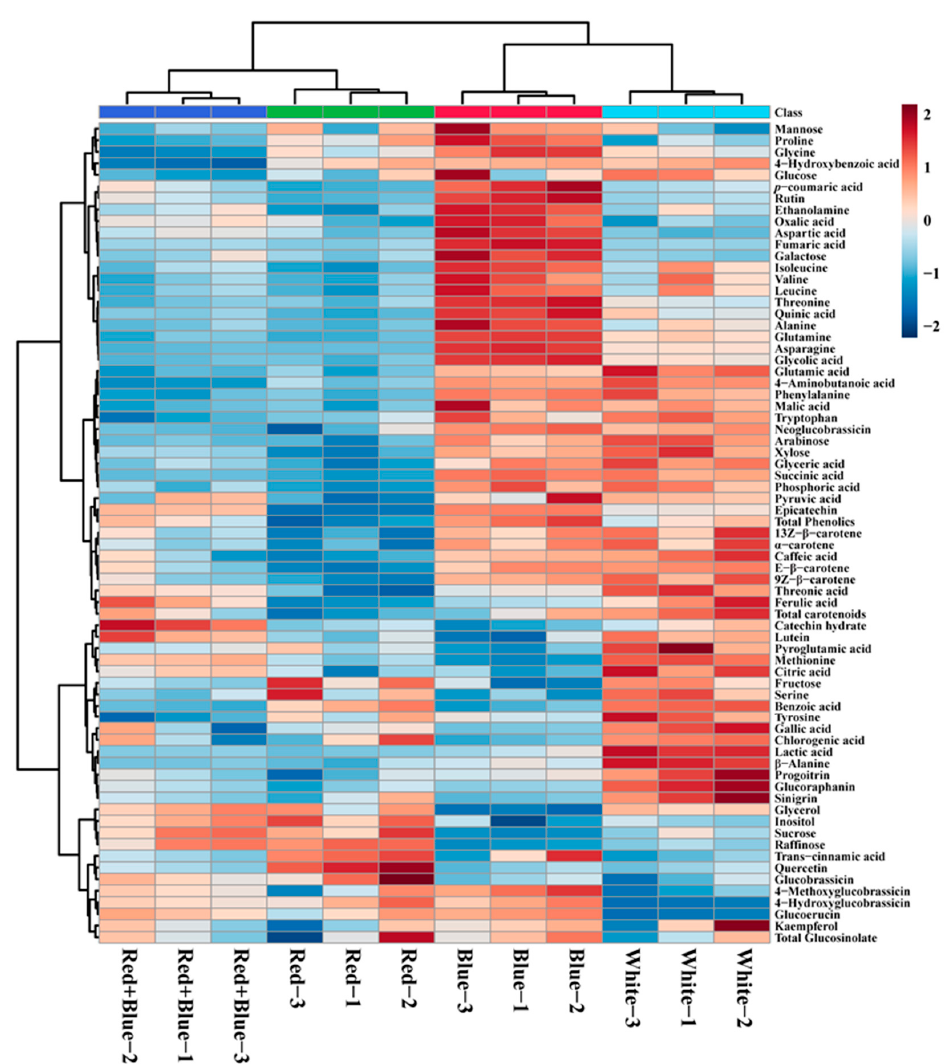
Figure 6. Heatmap showing the di ff erences in the relative metabolite content in kohlrabi sprouts after exposure to di ff erent LED light conditions. The blue color represents an increase in the metabolite content, and the red color denotes a decrease in the metabolite content. The PCA results supported the metabolic pro fi ling results obtained from kohlrabi sprouts treated with di ff erent LED lights (white, red, blue, and red + blue). The results of the PCA analysis showed that the metabolites obtained from the di ff erent LED light treat- ments showed 47.6% and 27.8% of the variance with a two-component analysis (principal